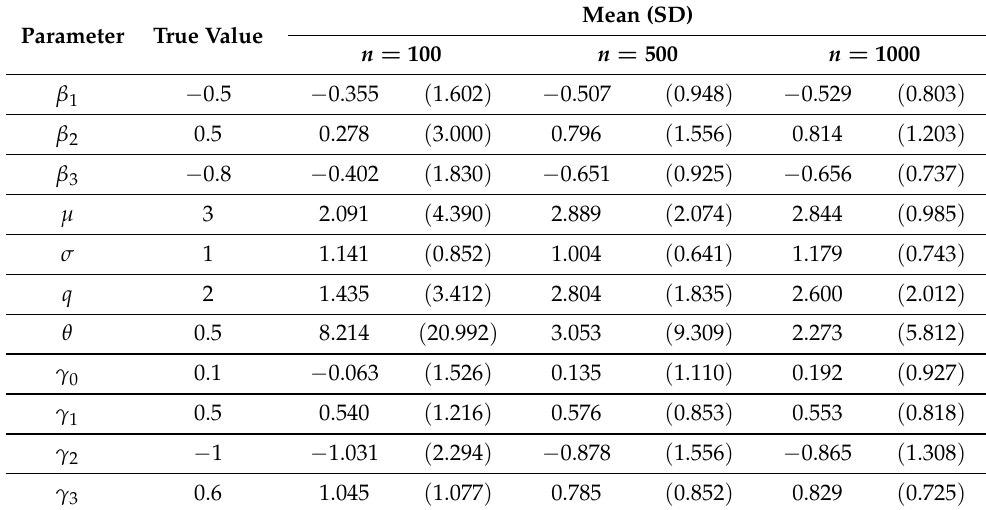
Table 2. Means and standard deviations (SD) of estimate values in setting (i).